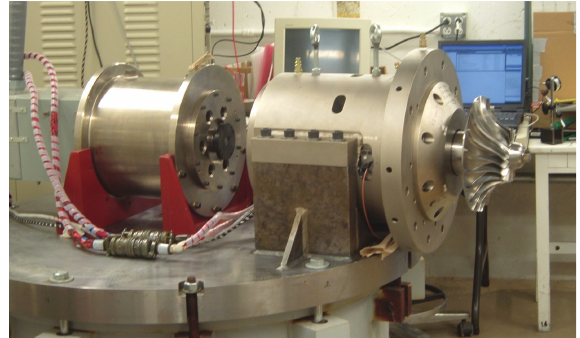
Figure 3: Induction motor and compressor without front volute.